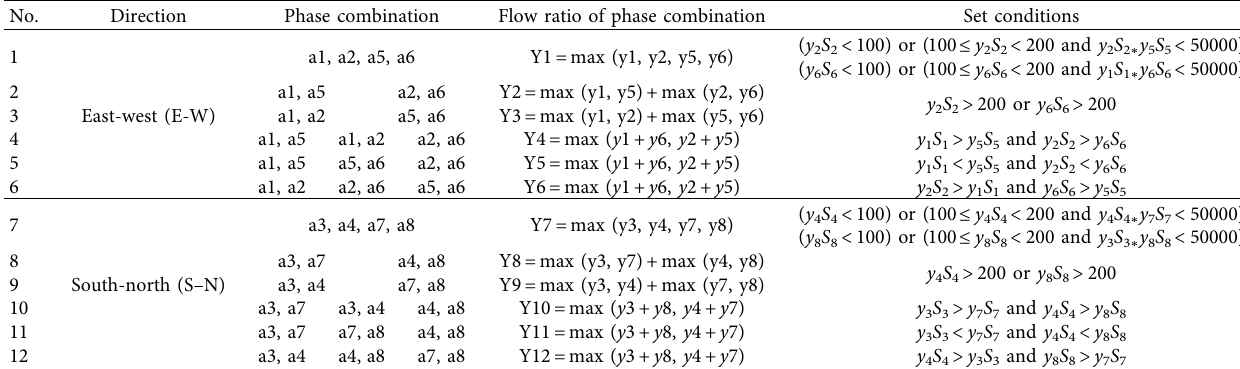
Table 1: Phase schemes and fow ratio calculation of the controlled trafc fow at intersection. No.